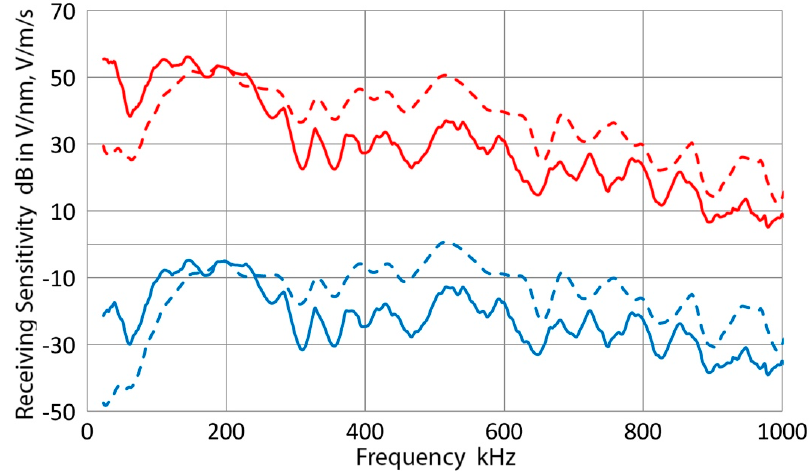
Figure 17. Receiving sensitivity of PAC HD50 (NL91). The displacement receiving sensitivities are shown in blue curves and velocity sensitivities are in red. Solid lines are for the bar-wave data, while dashed curves are for the sensitivities to normally incident waves.